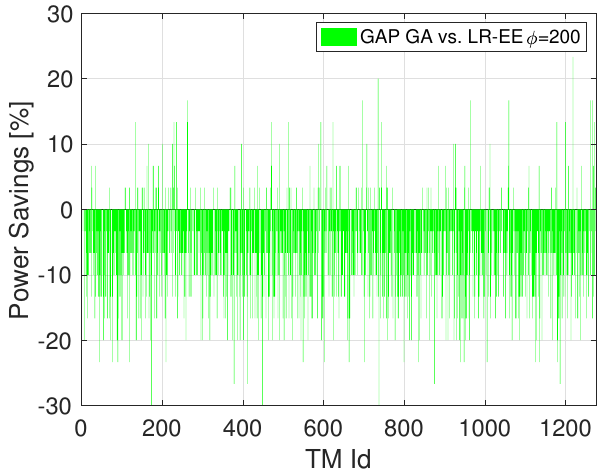
Figure 5. Power saving GAP of GA vs. LR-EE with φ =